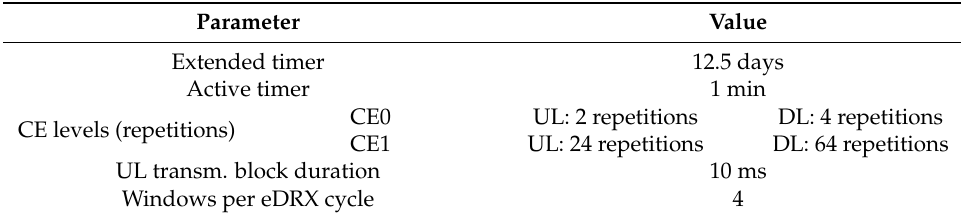
Table 7. Configuration of the preferred NB-IoT link.